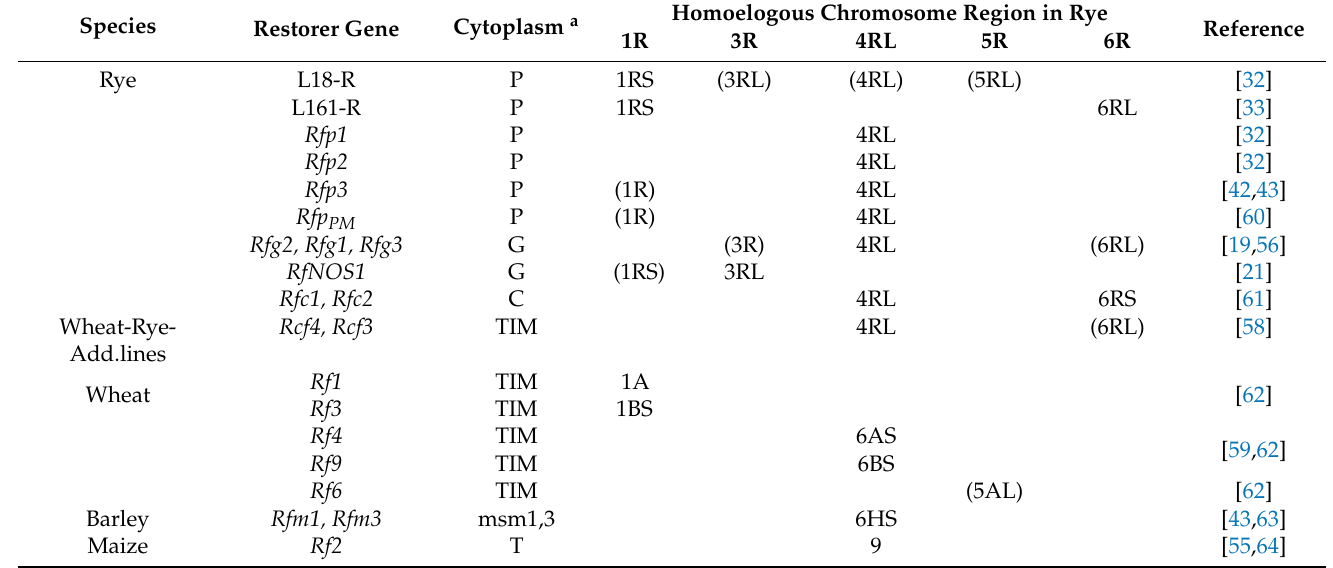
Table 2. Restorer genes mapped in syntenic regions of rye, wheat, barley, and maize (minor genes in